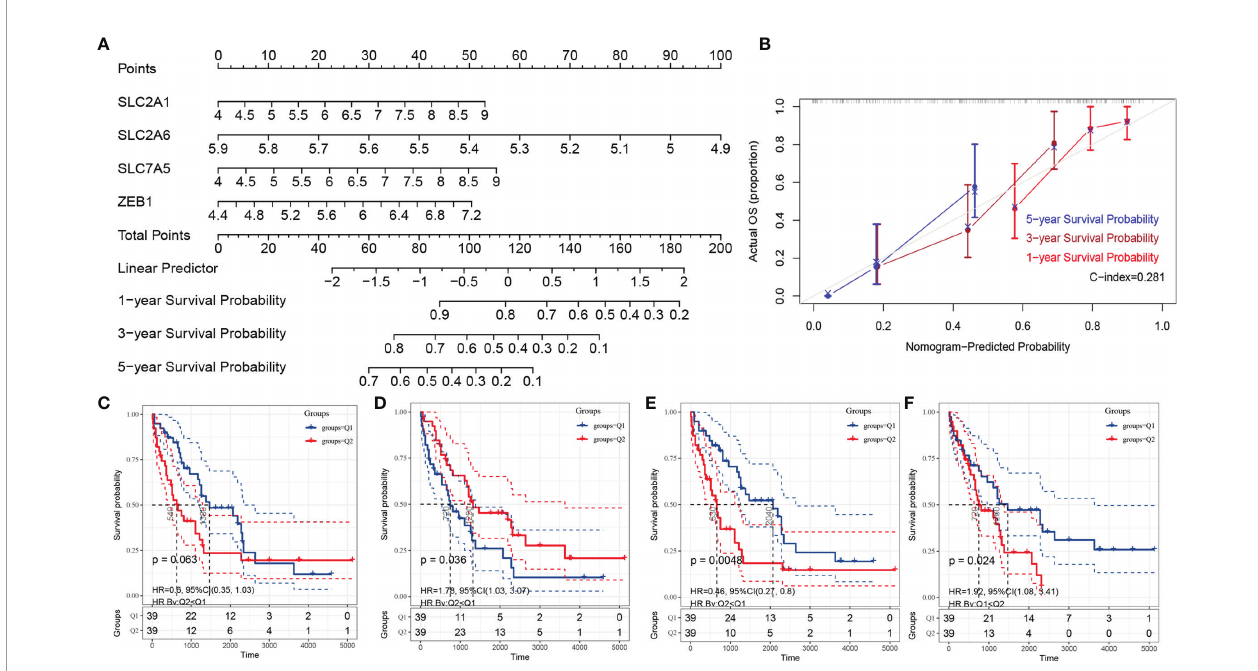
FIGURE 5 | The nomogram of the Fer-score model and single-gene KM survival curve. (A, B) are the nomogram and calibration curve of the Fer-score model, respectively. (B – F) KM survival curves according to SLC2A1, SLC2A6, SLC7A5, and ZEB1 (Q1 is the low-risk group, and Q2 is the high-risk